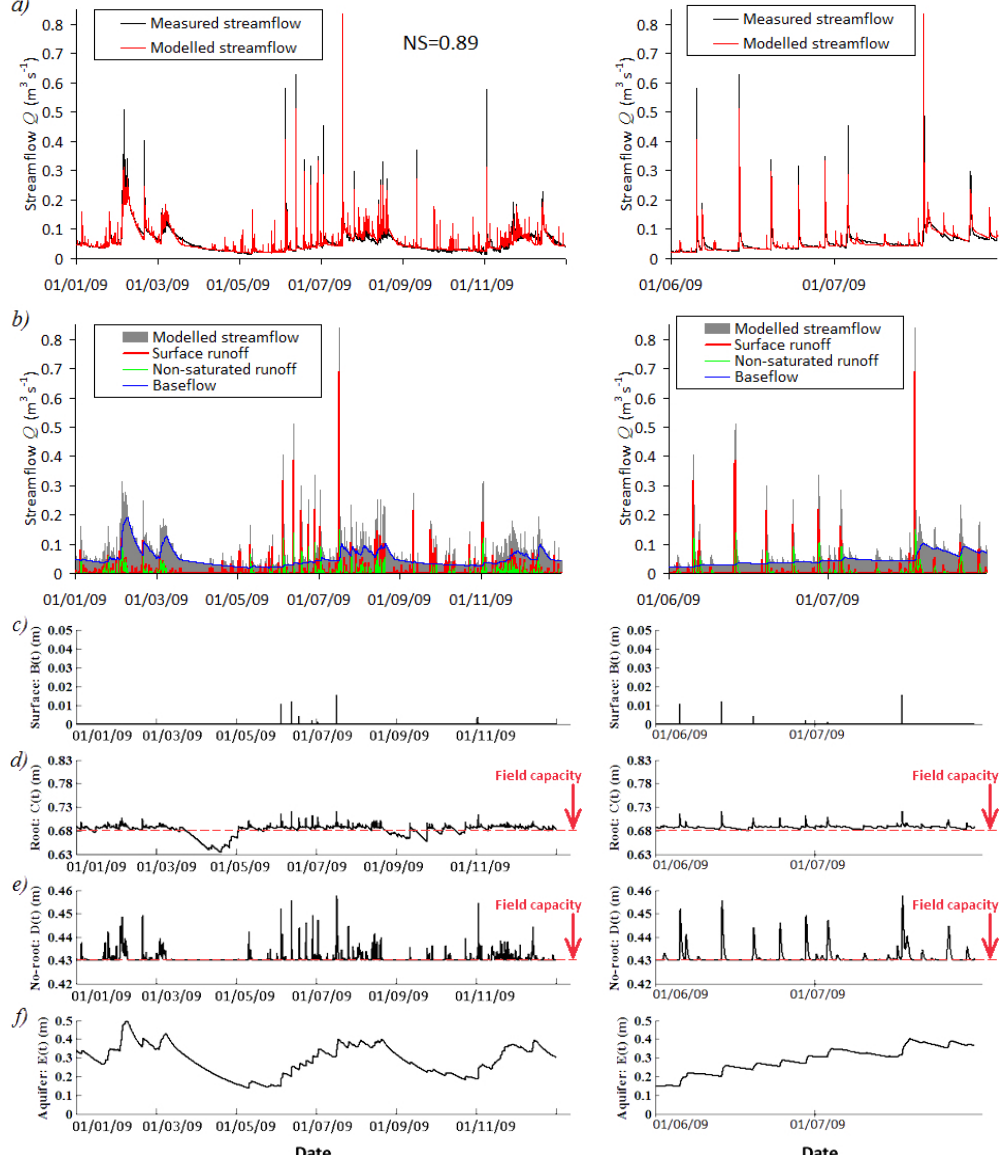
Fig. 7. Model results: (a) measured vs. modelled streamflow and (b) components of modelled streamflow. Water level in the model reservoirs: (c) surface reservoir, (d) non-saturated root reservoir (offset by θ r C H to show the absolute water content in the soil layer), (e) non-saturated non-root reservoir (offset by θ r D H ) and (f) aquifer reservoir. Graphs on the right side correspond to a two-month period (June–July 2009) for better